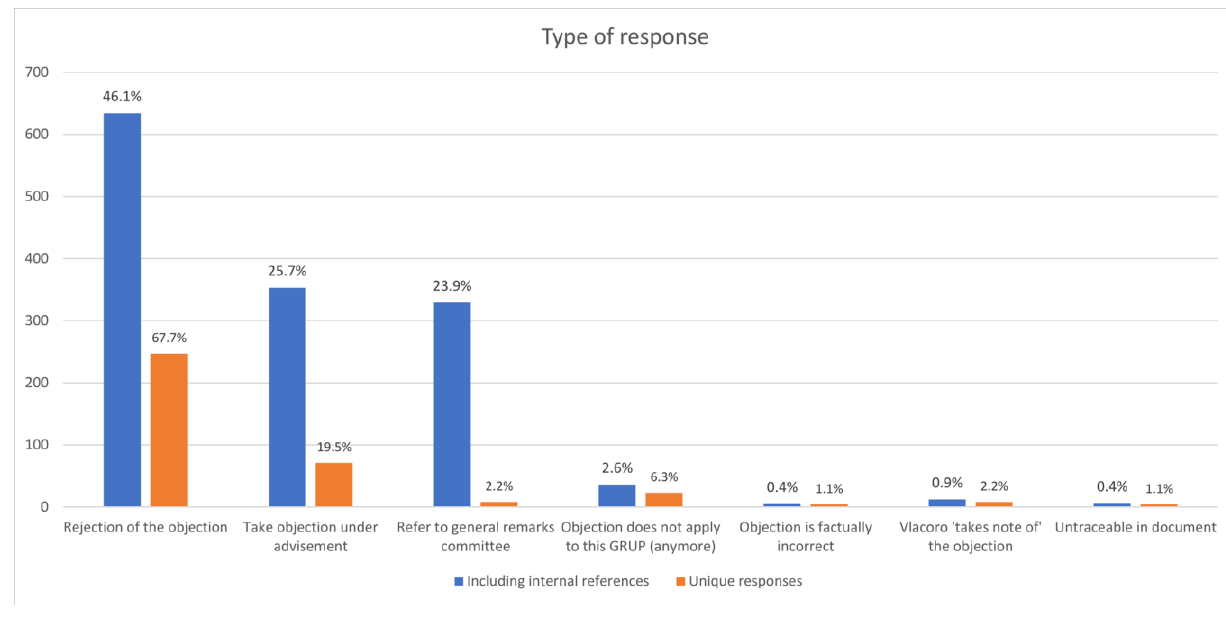
Figure 3. Arguments used in the responses to objections (including internal references).